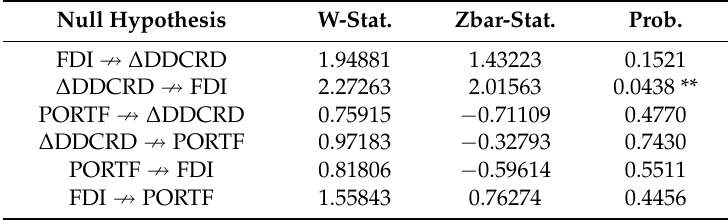
Table 6. Causality test